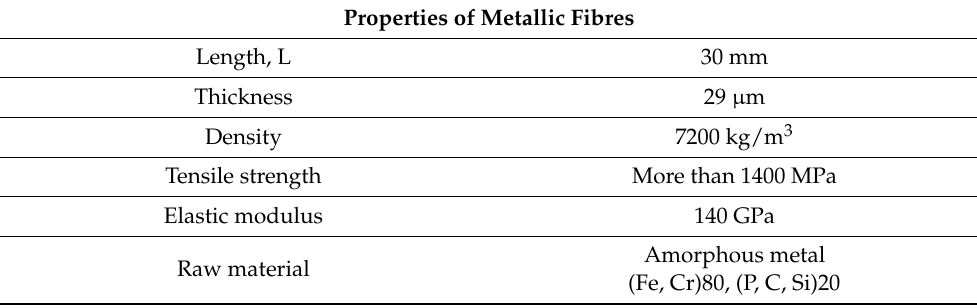
Table 2. Properties of metallic fibres (Fibraexsaint-Gobain [21]).